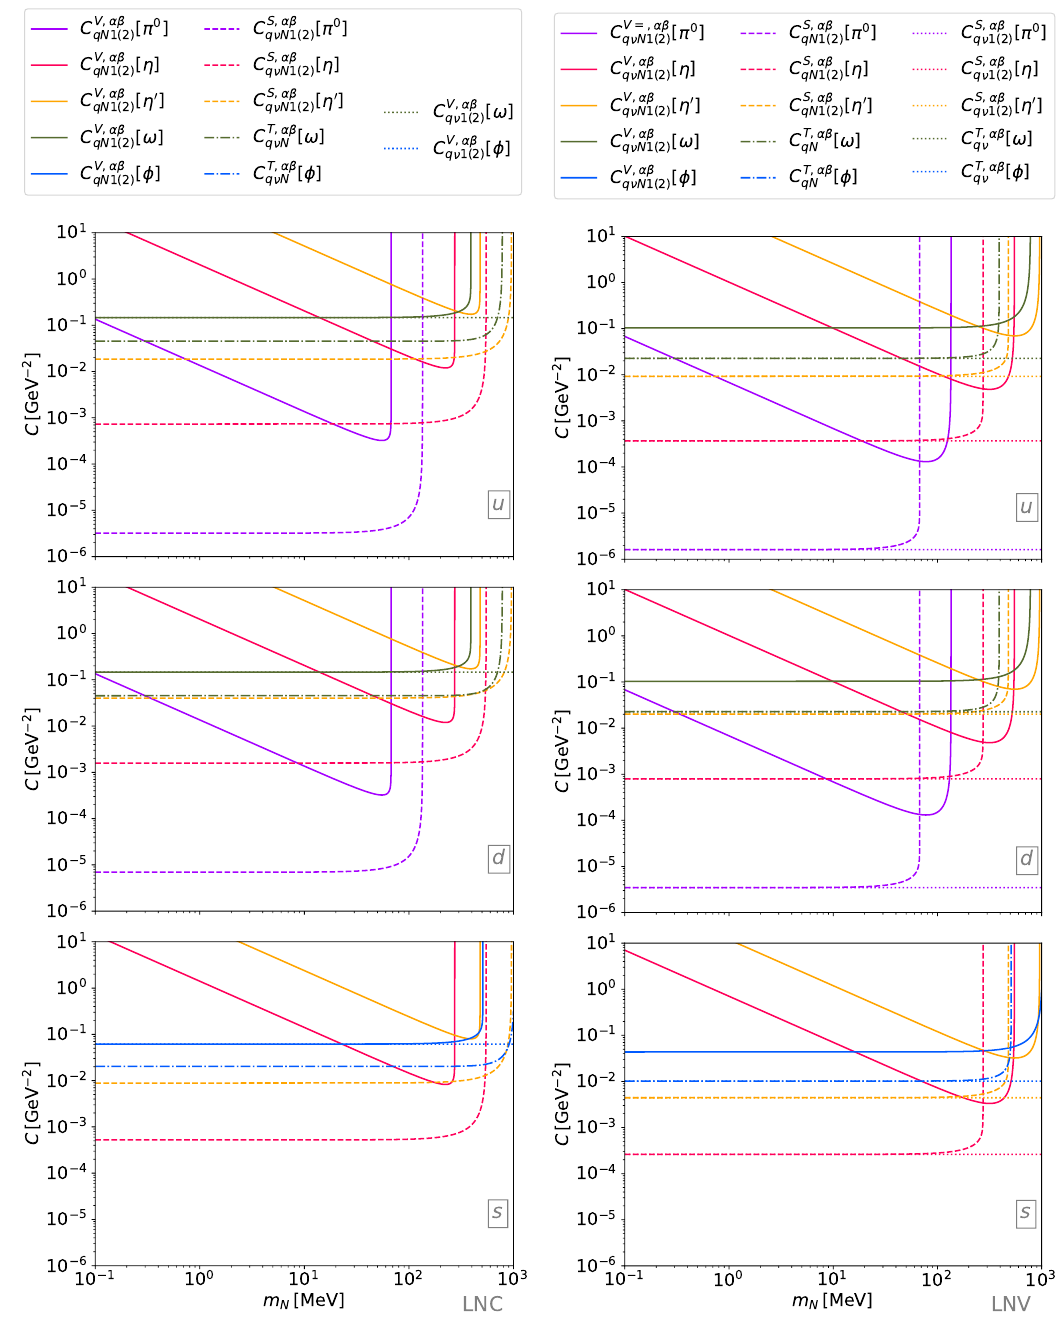
Figure 2 . Upper bounds on the LNEFT Wilson coe(cid:14)cients of dim-6 neutrino-quark operators from meson invisible decays as a function of m N for LNC (LNV) operators on the left (right). The top (middle) [bottom] row show WCs for up (down) [strange] quarks. For the LNV WCs C S;(cid:11)(cid:12) C S;(cid:11)(cid:12) we display the components with (cid:11) 6 = (cid:12) . The bounds for the corresponding WCs with (cid:11) = (cid:12) qN 1(2) p are stronger by a factor 2.